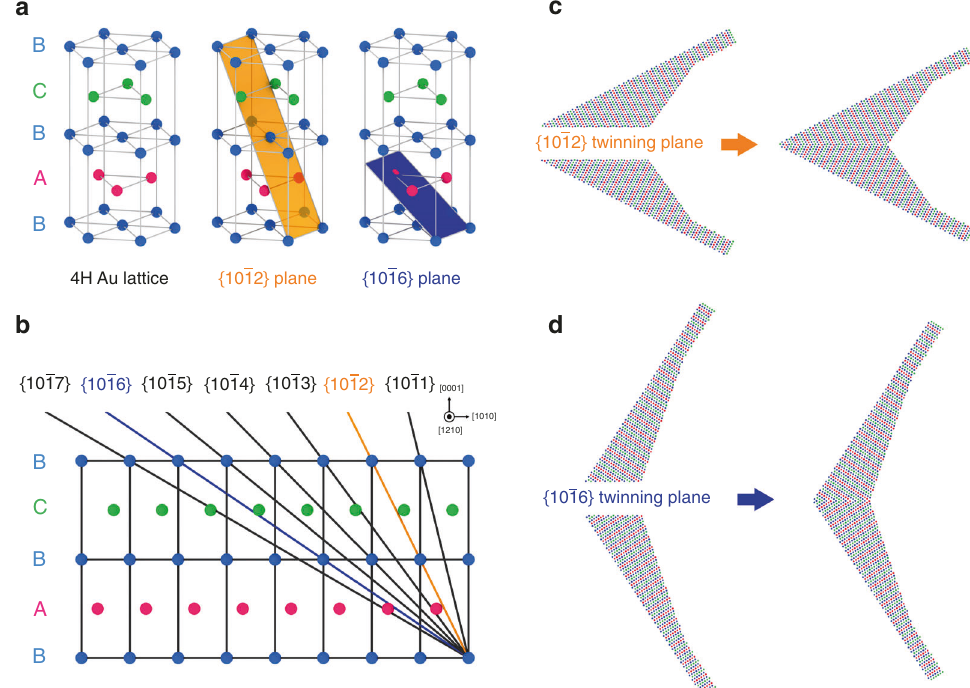
Fig. 3 Determination of the atomic structures of 4H-phase twin boundaries in Au nanokites. a Schematic models of the hexagonal unit cell of a 4H-phase Au lattice, the {1 0 (cid:1) 1 2} twinning plane, and the {1 0 (cid:1) 1 6} twinning plane. b Schematic models of different twinning planes of 4H-phase Au lattice viewed in the [1 (cid:1) 2 1 0] direction. c , d Schematic models of acute-angled ( c ) and obtuse-angled ( d ) twinned nanokites built from two pieces of 4H-phase sub-crystals with {1 0 (cid:1) 1 2} and {1 0 (cid:1) 1 6} twinning